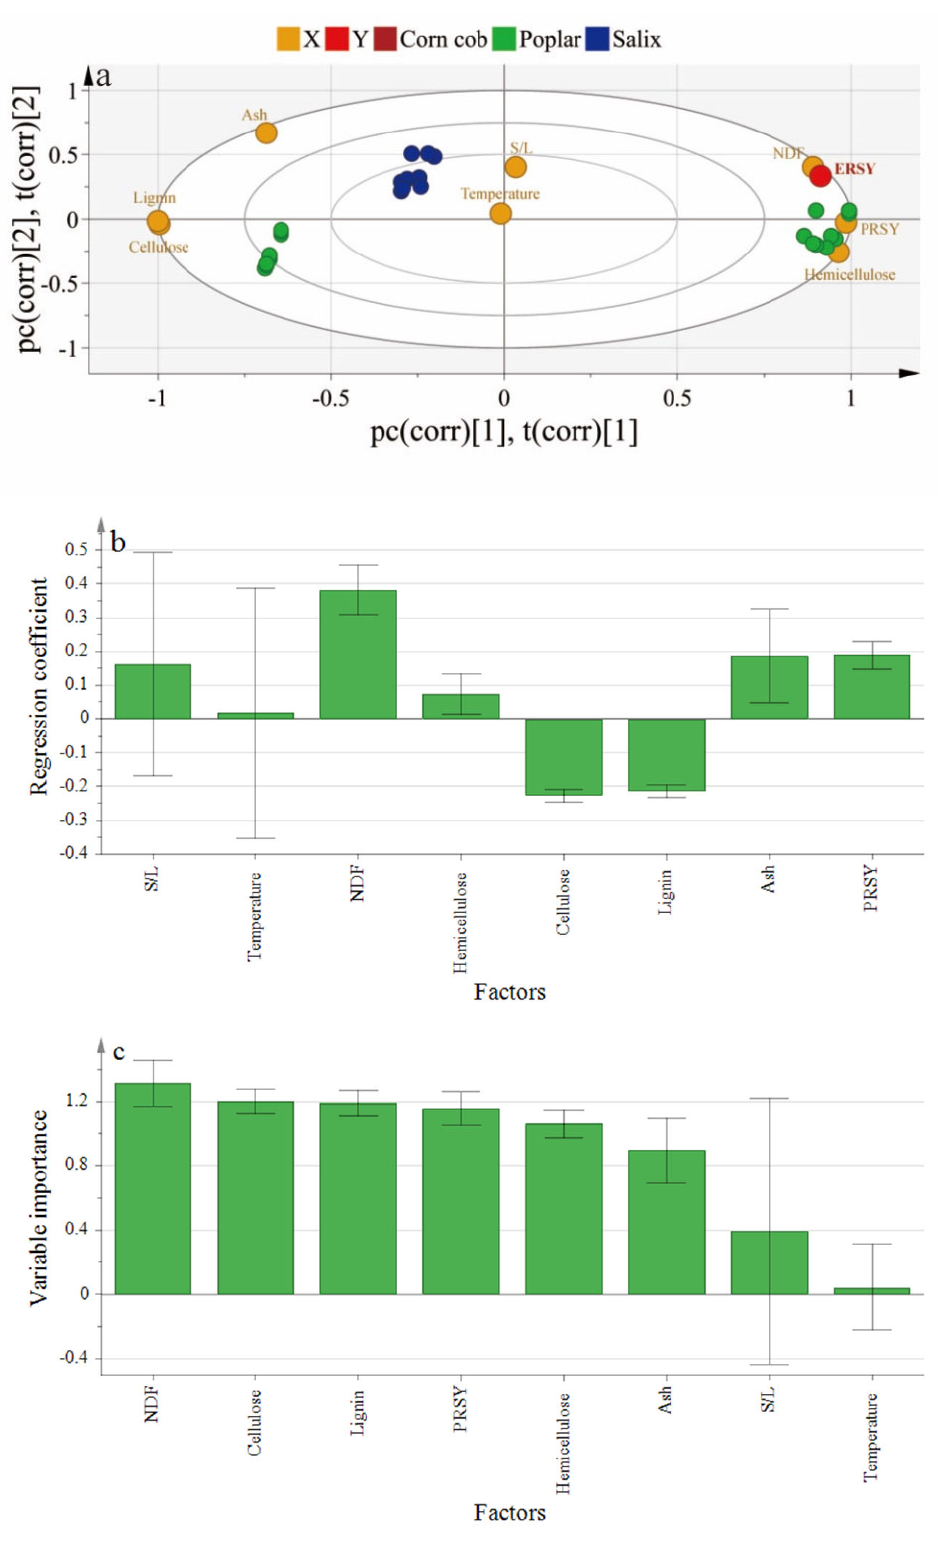
Figure 4. PLS model 3 analysis for the hot water pretreatment followed by enzymolysis. ( a ) Biplot. ( b ) Regression coefficients of X variables on the Y variable. ( c ) Importance of X variables on the Y variables for the projection.